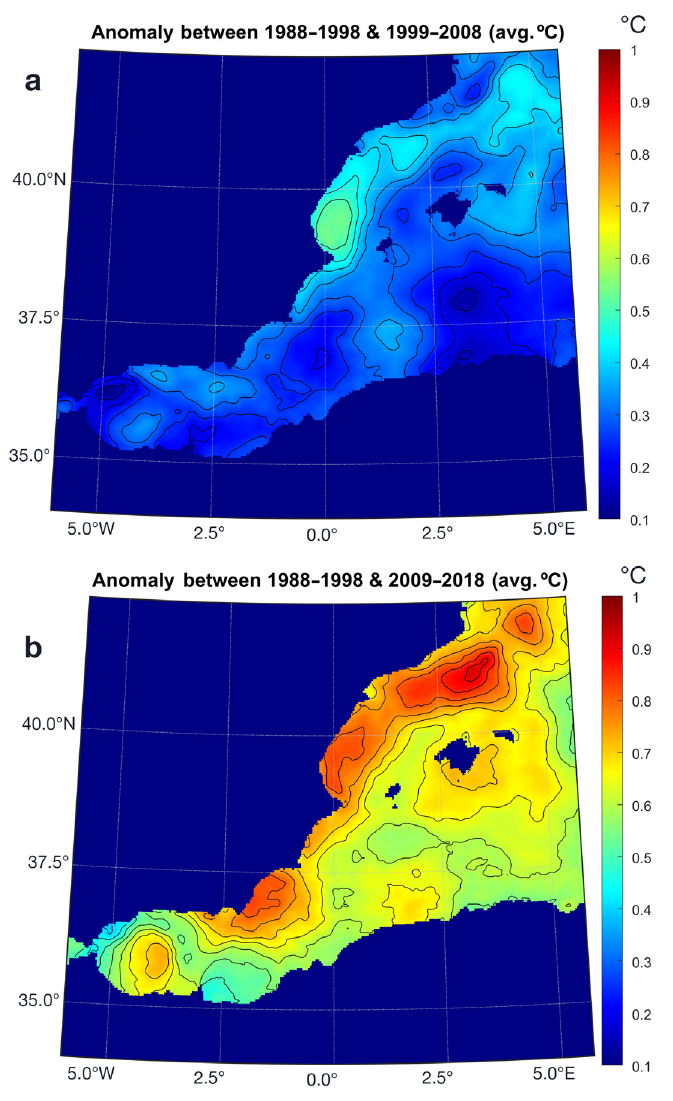
Fig. 2. Thermal anomaly for the period (a) 1999−2008 com- pared to 1988− 1998 and (b) 2009−2018 compared to 1988− 1998. Generated and provided by Copernicus Marine Serv- ice and Consiglio Nazionale delle Ricerche−Gruppo di Oceano grafia da Satellite (CNR−GOS),